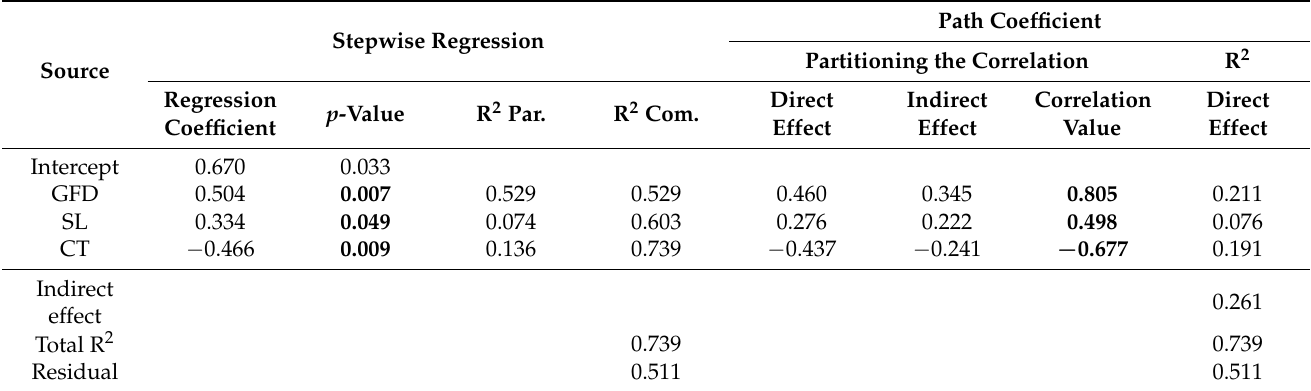
Table 5. Stepwise regression and path coefficient analyses for grain yield (dependent index) with three yield-related traits (independent indices) for combined data across the two seasons.